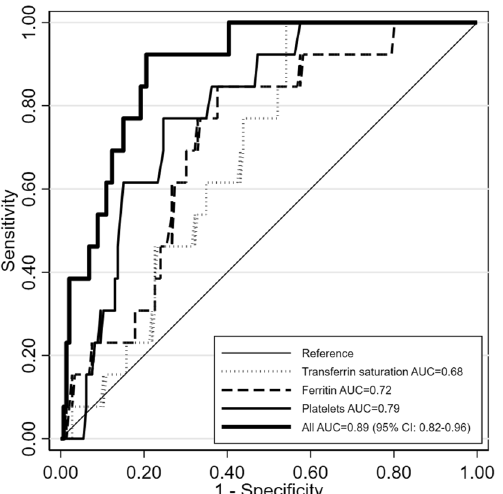
Figure 2. Receiver operating characteristic (ROC) curves of GD1 for platelets (thousands/mm 3 ), ferritin (μg/L), transferrin saturation (%), and for the three variables jointly analyzed in a multiple logistic regression model. AUC area under the curve, CI confidence